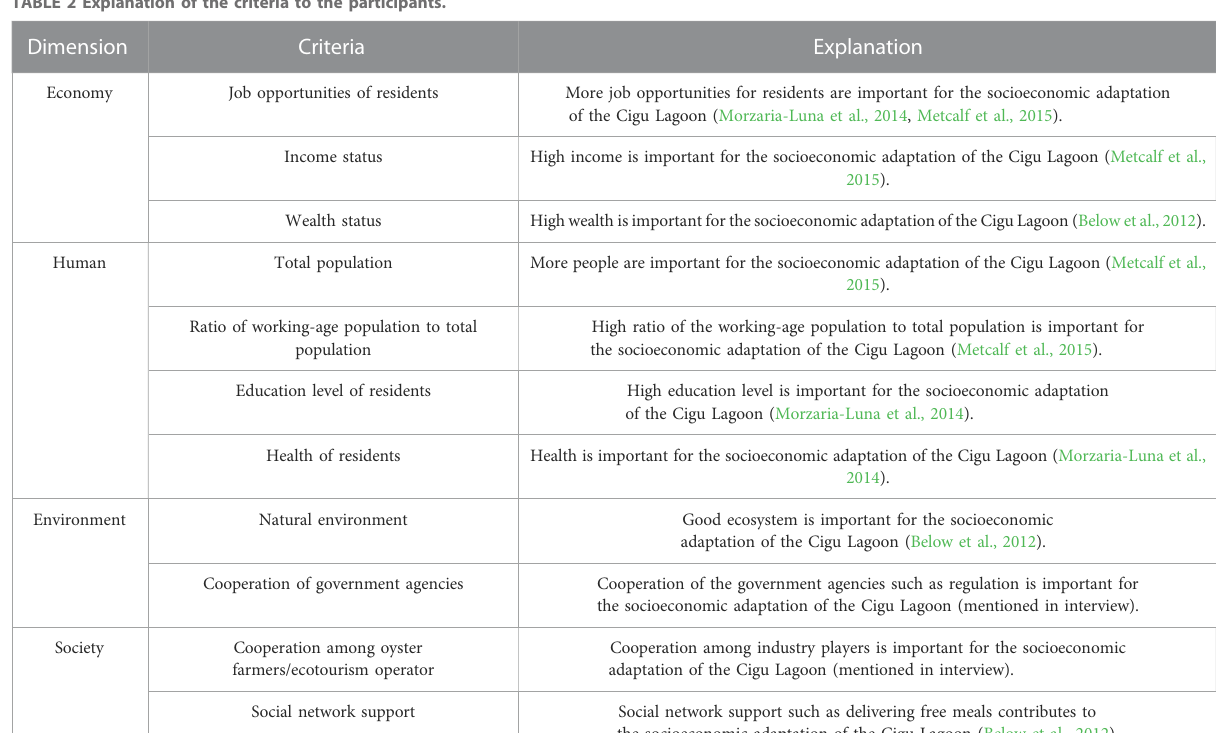
TABLE 2 Explanation of the criteria to the